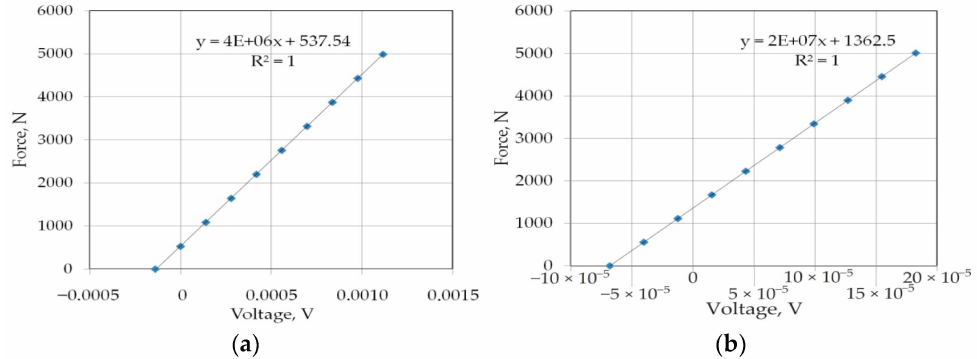
Figure 4. Calibration curves for strain gauge sensors measured for ( a ) pulling and ( b ) clamping forces. Angle Θ can be determined on the basis of the arrangement of rolls simulating the drawbead (Figure 4):